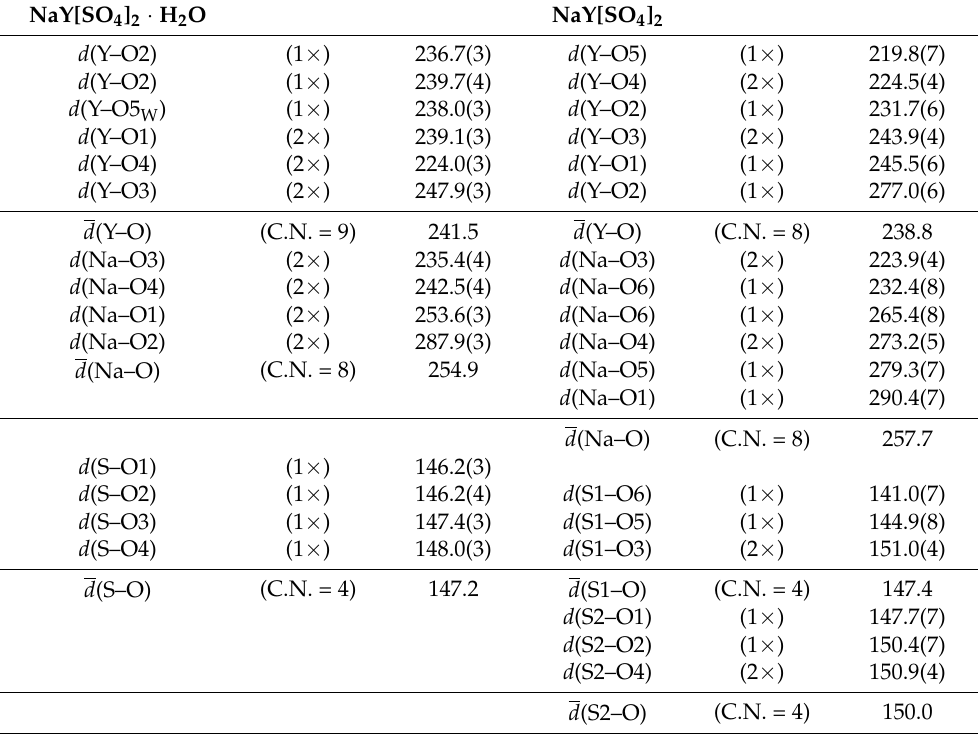
Figure 8. Coordination spheres of the oxygen atoms in NaY[SO 4 ] 2 · H 2 O ( left ) and NaY[SO 4 ] 2 ( right ). Table 3. Selected interatomic distances ( d /pm) in the crystal structures of NaY[SO 4 ] 2 · H 2 O ( left ) and NaY[SO 4 ] 2 ( right ).